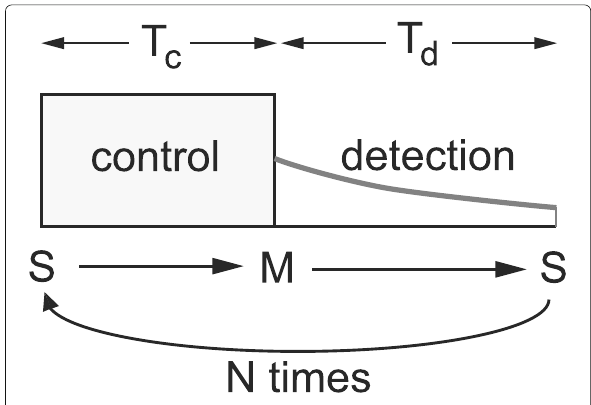
Fig. 1 Schematic representation of the cyclic process used in the maximization of the